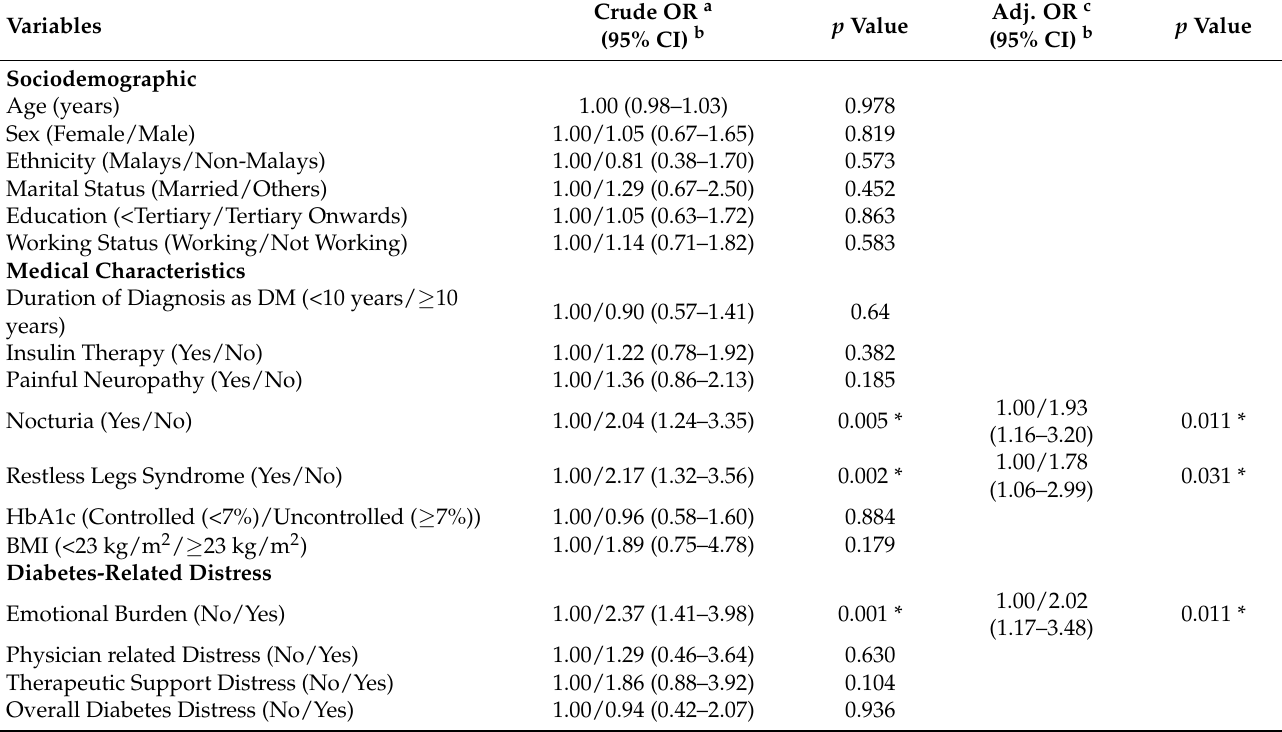
Table 3. Associated factors for poor sleep quality among patients with T2DM using simple and multiple logistic